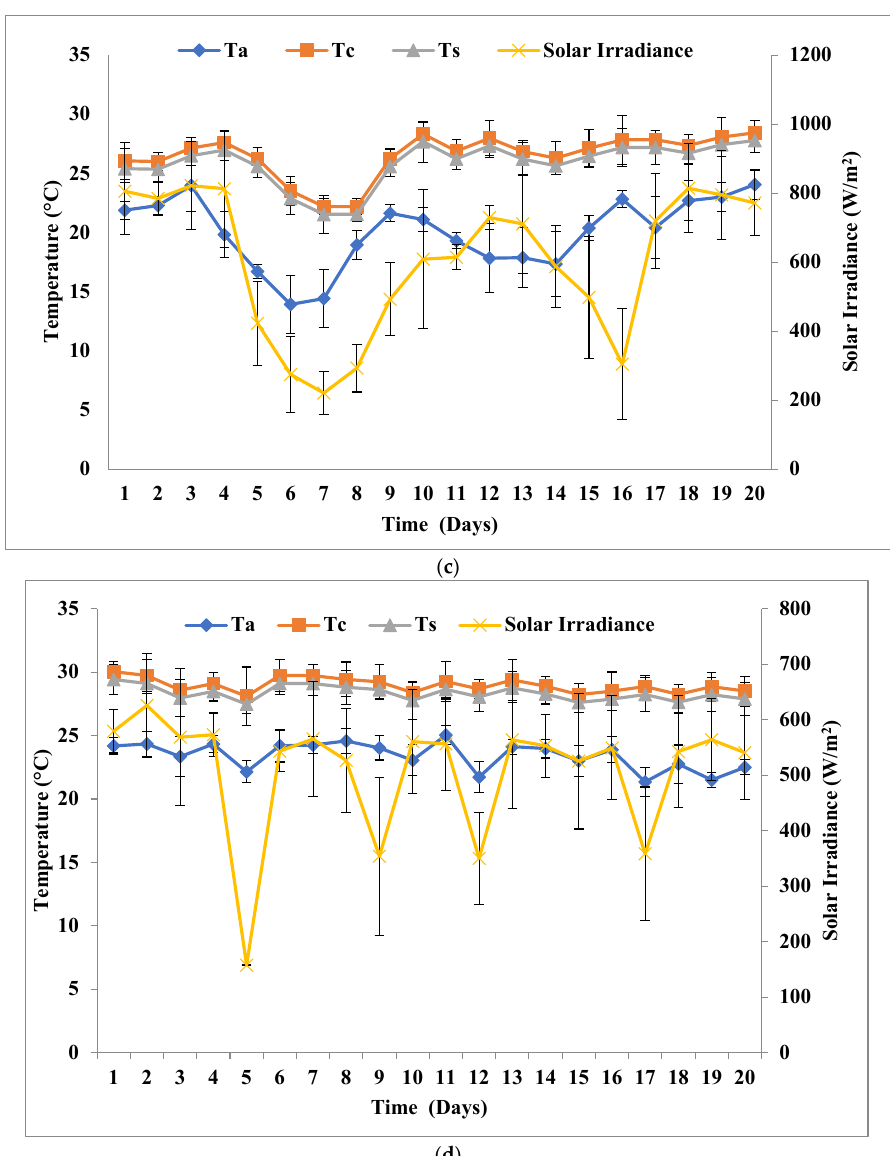
Figure 5. Solar irradiance and temperature at solar inclination angle 47.9°: ( a ) SPNY1; ( b ) ATMY1; ( c ) SPNY2; ( d ) ATMY2.